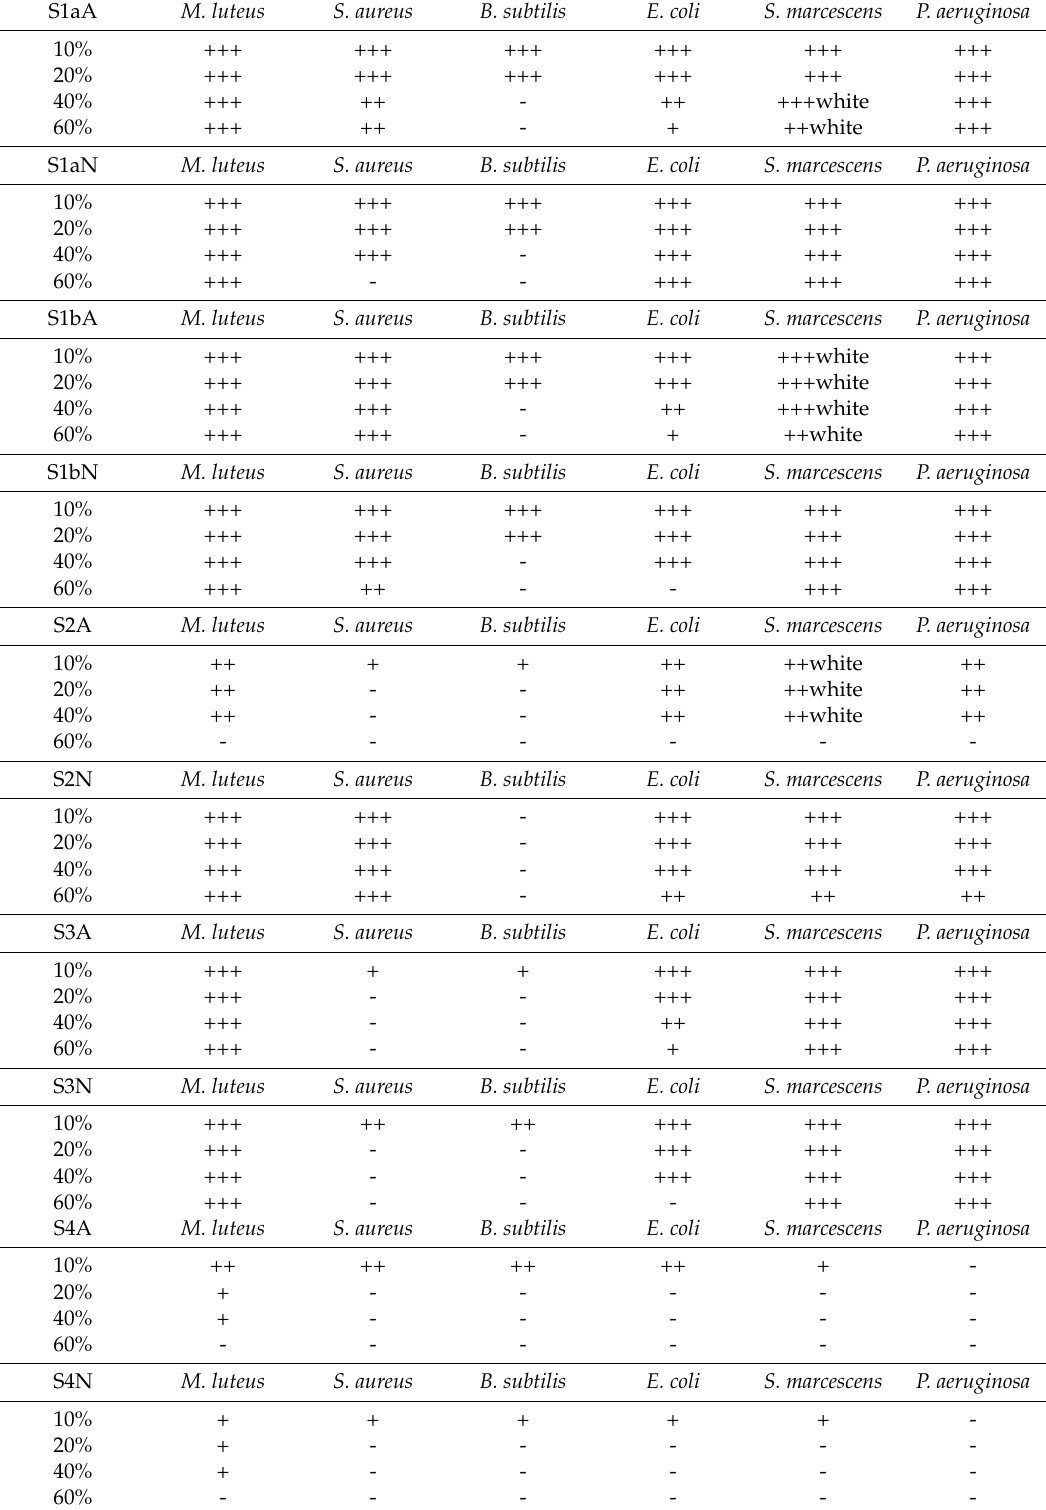
Table 3. Antibacterial efficiency of metallurgical slags regarding inhibition of growth of selected bacteria.